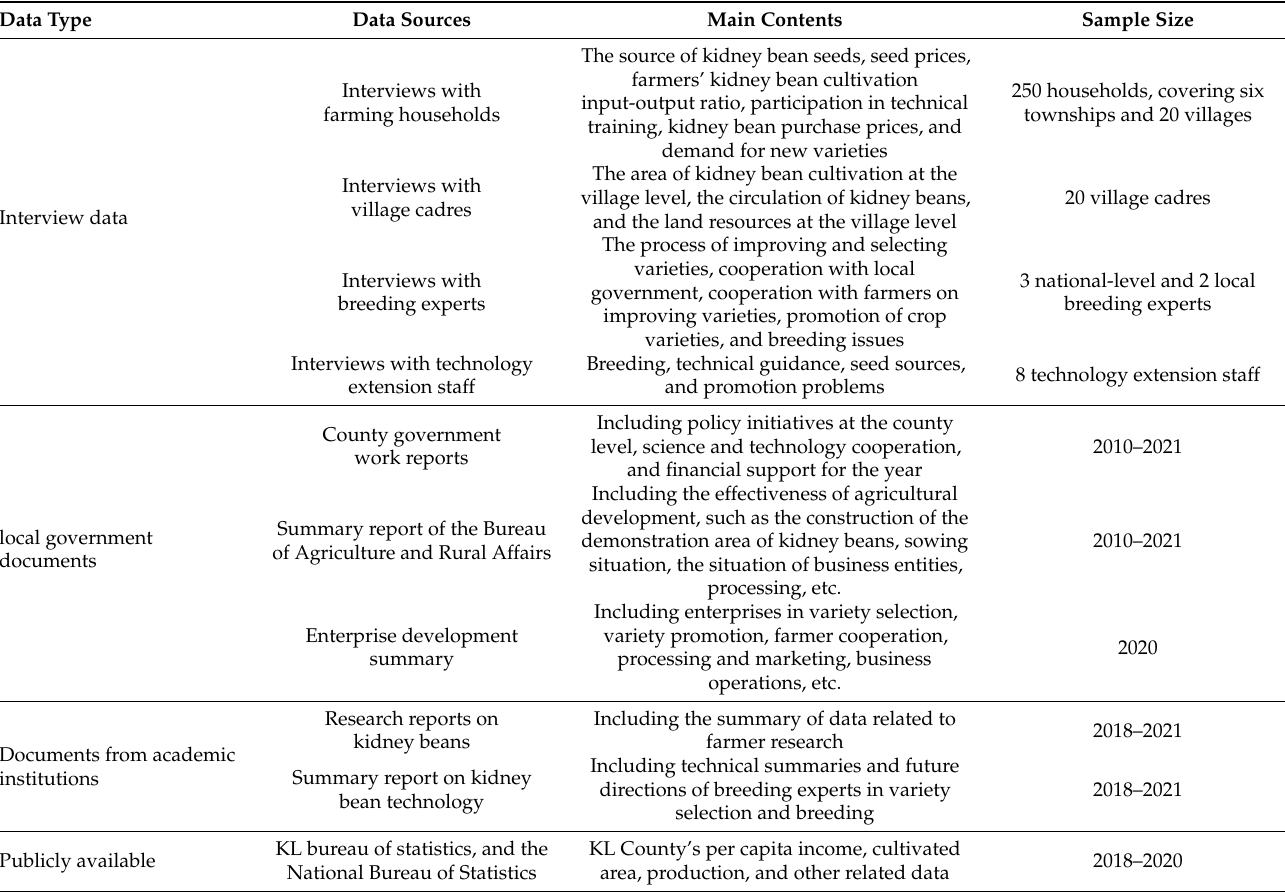
Table 1. Data sources and main